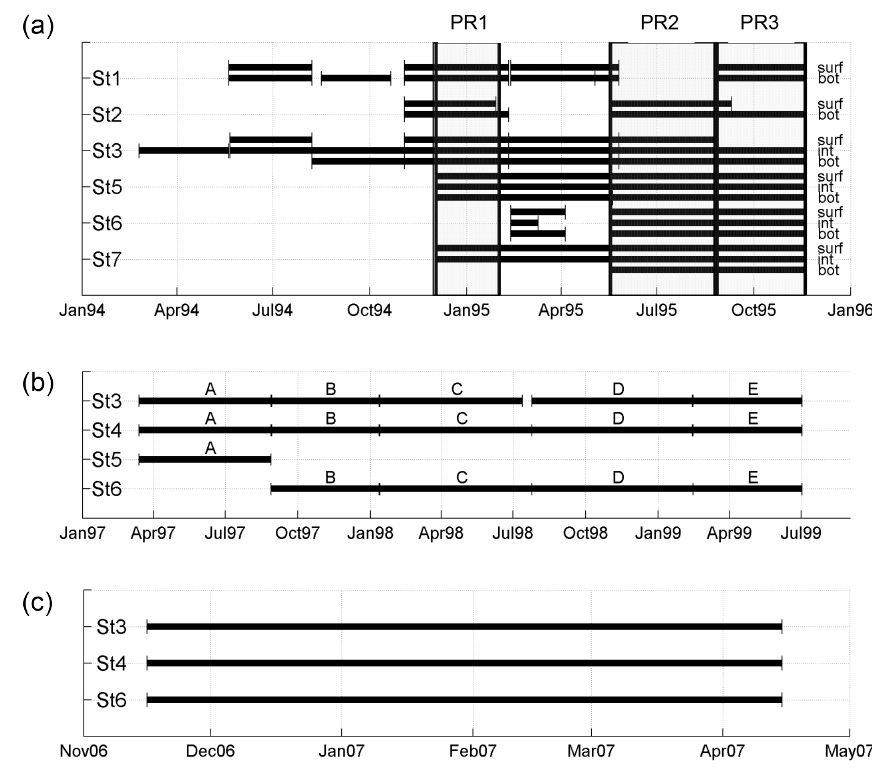
Fig. 2. Time diagram of the available current meter data within (a) the OTRANTO/OGEX projects. Shaded areas correspond to time intervals for which rotary spectral analysis was done (PR1, PR2, and PR3) (b) MATER project. Time intervals A, B, C, D and E are indicated. (c) VECTOR